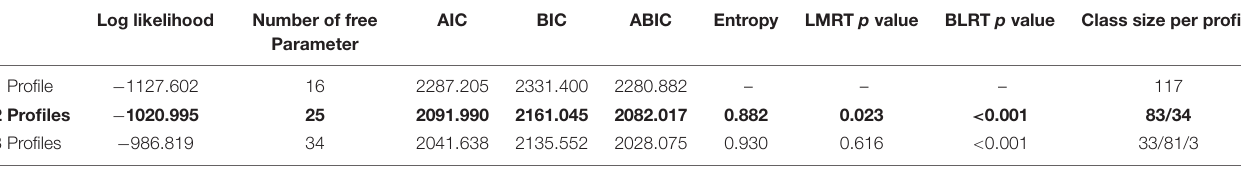
TABLE 3 | Summary of latent profile models.